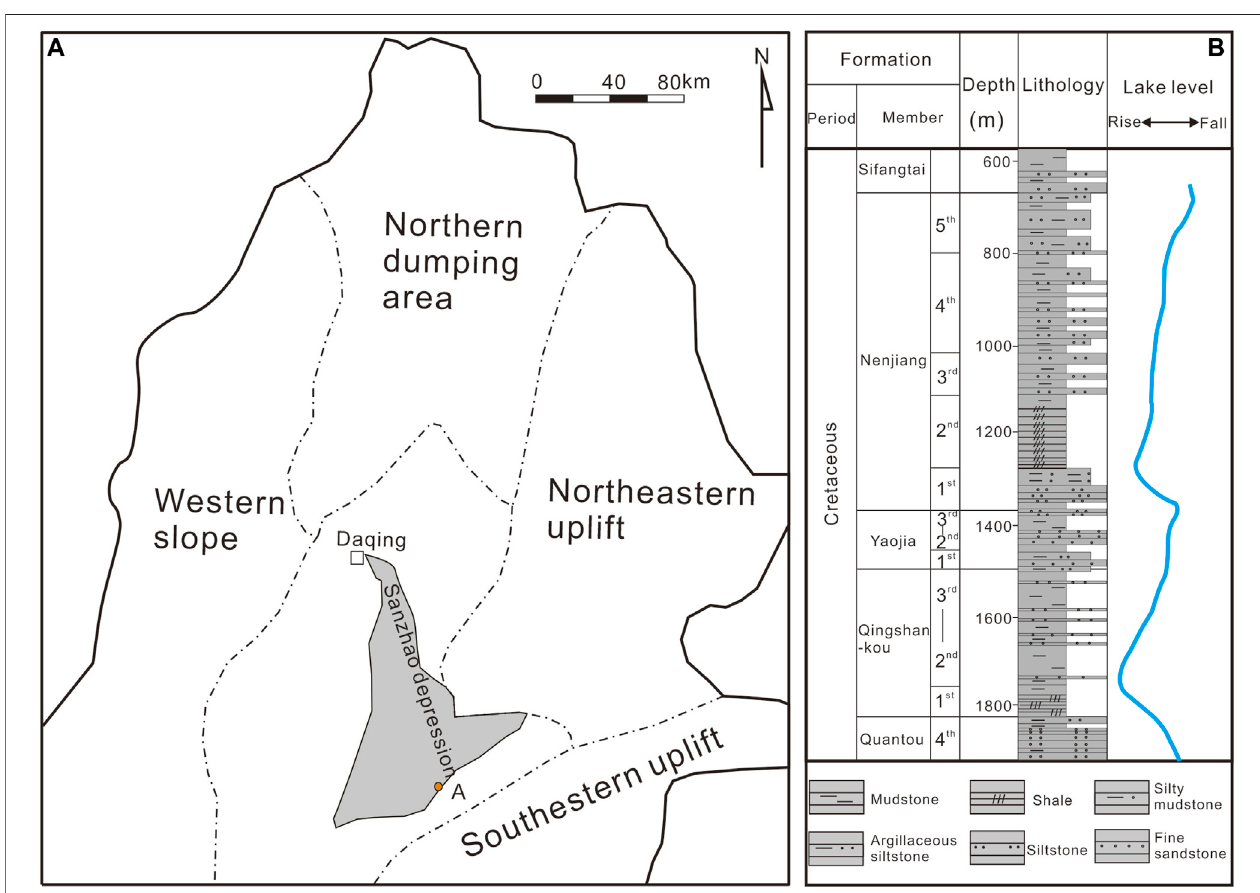
FIGURE 1 | Location map (A) and strata column (B) of the study